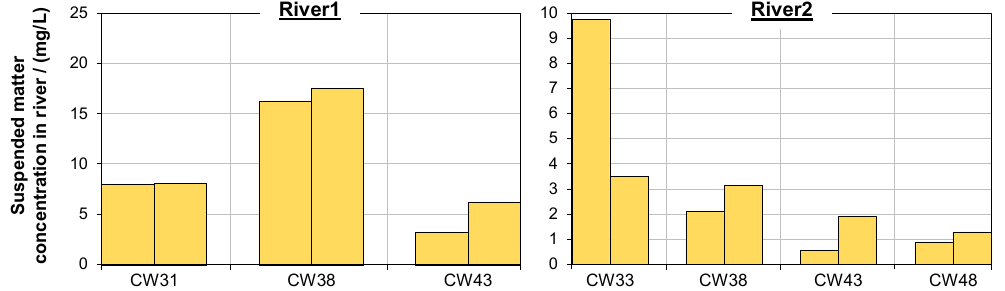
Figure A4. Suspended matter concentrations in both rivers investigated before ( left columns ) and behind the WWD ( right columns ).